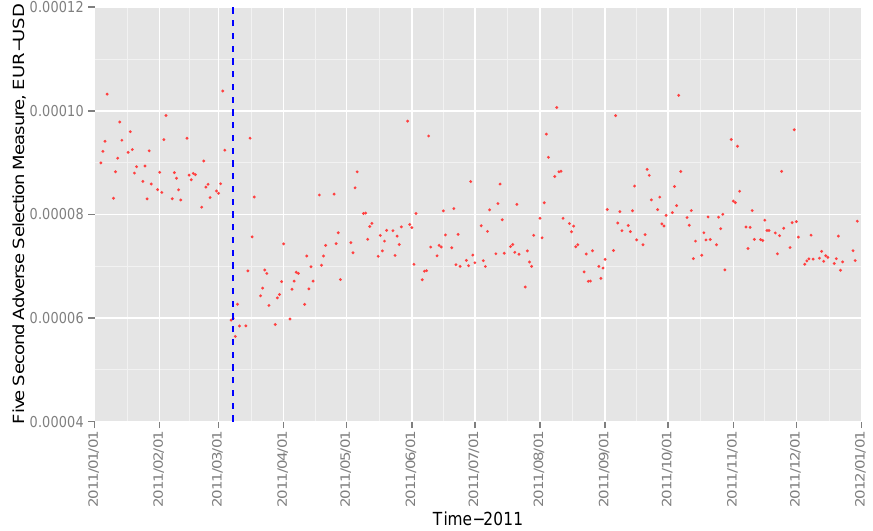
Figure 12. EUR/USD Adverse Selection Proxy, Five-Second